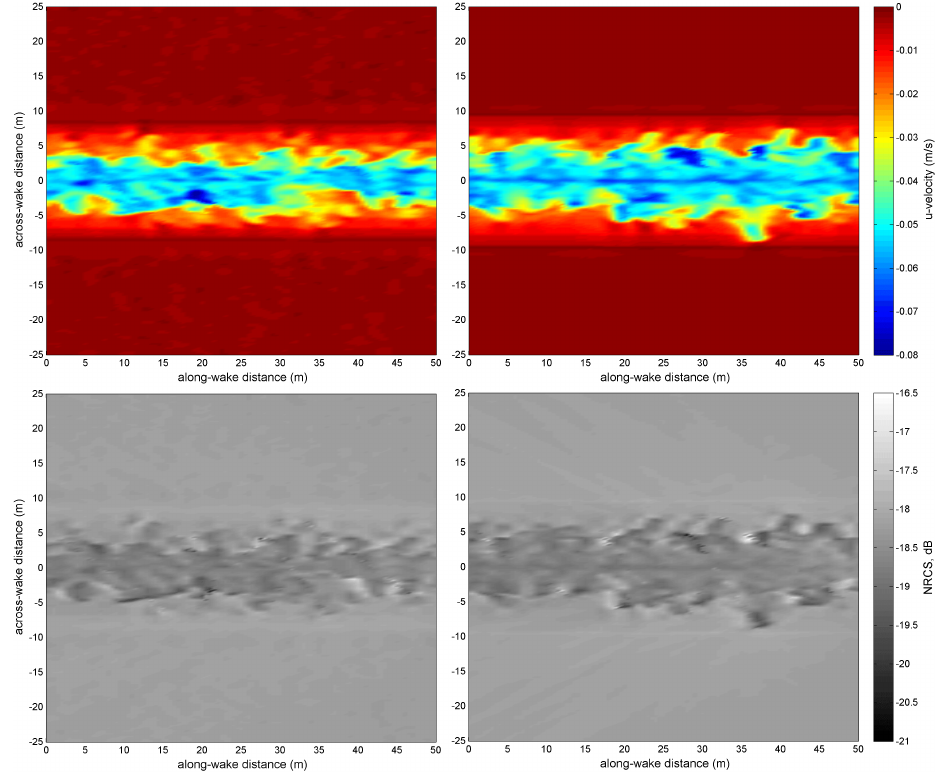
Figure 3. Ship wake signature at the surface in the velocity field (top, in ms − 1 ) and radar backscatter intensity map (bottom; as normalized radar cross section (NRCS), dB values here should be taken as a relative range) for the case without ambient stratification (left) and with ambient stratification (right). Taken at time t = 575s.